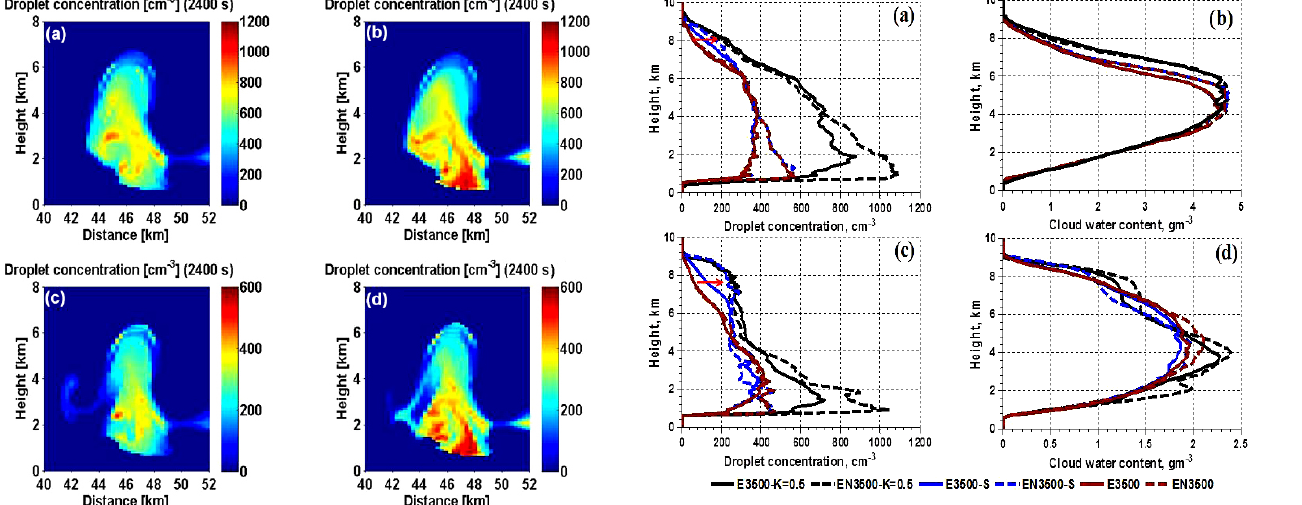
Figure 3. Field of droplet concentration at t = 2400s in (a) E3500- S-0.5, (b) EN3500-S-0.5, (c) E3500-S, and (d) EN3500-S.